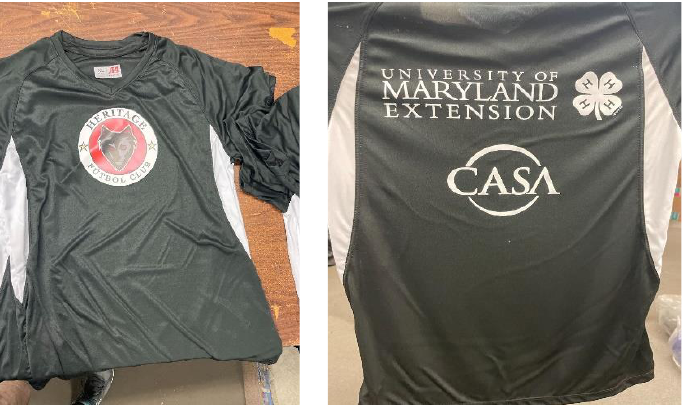
Figure 3. Custom-designed soccer jersey (front and back).